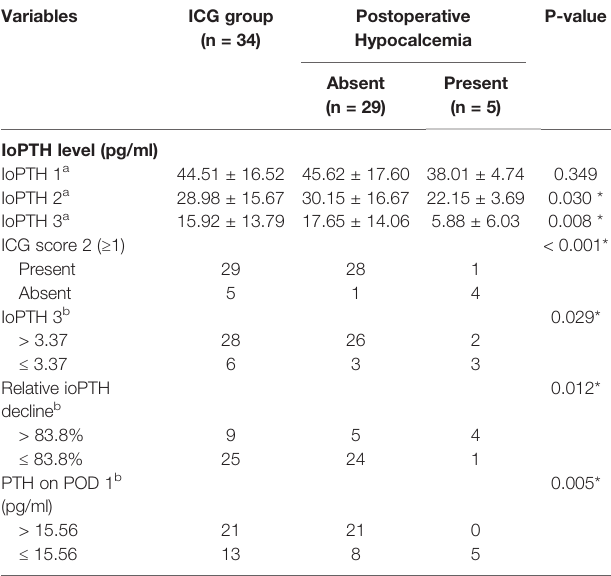
TABLE 4 | Distribution of patients in the ICG group according to predictors of early postoperative hypocalcemia.